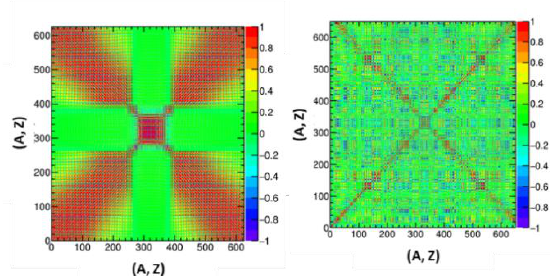
Fig. 8. The correlation matrices of post-neutron fission yields based on Wahl-like approach (left) and direct-Zp approach (right). The axes represent the isotope indexes.